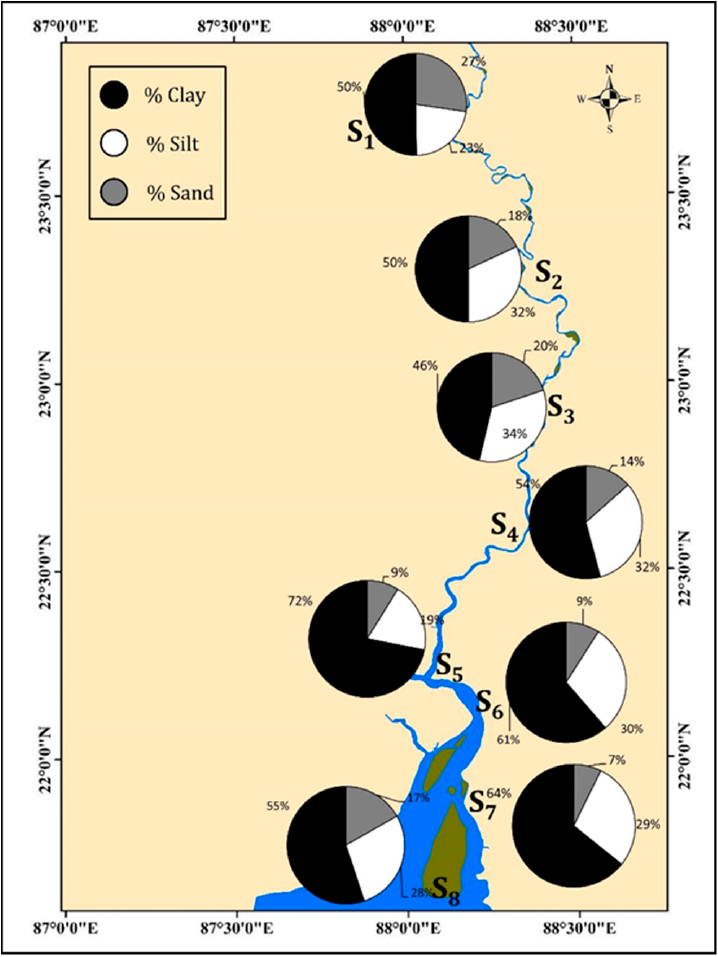
Figure 2. Spatial distribution of grain ‐ size fractions along the Hooghly (Ganges) River Estuary. Mineralogical studies of sediment revealed that they are not only sensitive indicators of their environment, but also provide valuable insight into regional hydrodynamics, in- cluding patterns of sediment transport and deposition [28,29]. The clay minerals identified in sediment samples are quartz (Q), illite (I), chlorite (Ch), oligoclase (O) and rutile (R). The XRD plots showed that quartz has the strongest peak along with illite, chlorite, and oligoclase (Figure S1) similarly to the results from Rupnarayan river [30]. Rutile was exclusively identified in sediment during the pre-monsoon season at Barrackpore (S 2 ), during monsoon (at Budge Budge (S 4 ), Nurpur (S 5 ), Diamond Harbour (S 6 ), Lot 8 (S 7 ) and Jyotirampur (CS)) and in sediment of Babughat (S 3 ), Diamond Harbour (S 6 ), Lot 8 (S 7 ) and Gangasagar (S 8 ) sampled during the post monsoon season. Minor differences in mineral composition were observed both in space and time. The mean seasonal variation of total hydrogen (TH) content (%) exhibited the follow- ing decreasing trend: pre-monsoon (1.13 ± 0.34) > monsoon (1.03 ± 0.35) > post-monsoon (0.26 ± 0.06). According to Table 1, The total carbon (TC) ranged from 0.76% at Diamond Harbour (S 6 ) to 1.57% at Gangasagar (S 8 ) during pre-monsoon, 0.73% at Diamond Har- bour (S 6 ) to 1.54% at Barrackpore (S 2 ) during monsoon and 0.47% at Lot 8 (S 7 ) to 1.40% at Barrackpore (S 2 ) during post-monsoon. Total Nitrogen (TN) as a chemical impact in- dicator of sediment organic enrichment [31] ranged from 0.08% at Jyotirampur (CS) to 0.71% at Gangasagar (S 8 ) during pre-monsoon and did not show significant temporal and spatial differences. In HRE, the TC/TN ratios ranged between 1.24 at Lot 8 (S 7 ) during monsoon to 7.65 at Nurpur (S 5 ) during post-monsoon season, revealing that organic